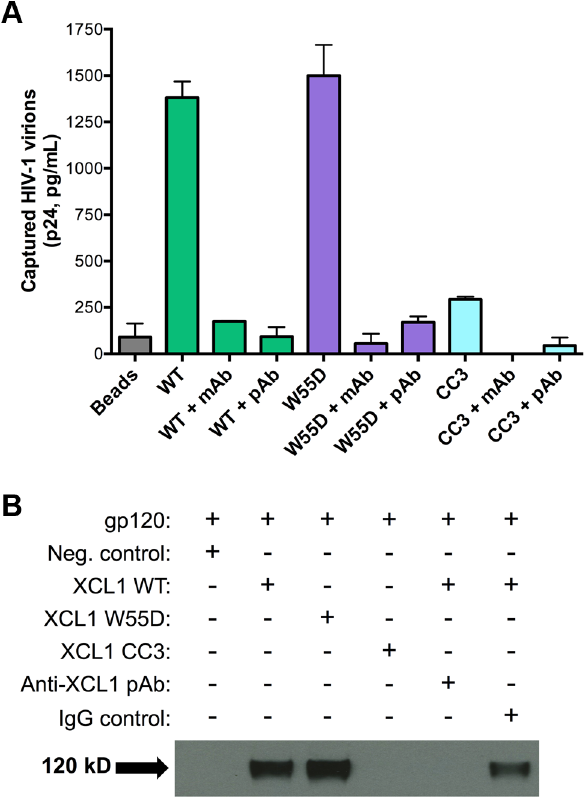
Figure 5. XCL1 captures native HIV-1 virions and interacts directly with the external viral envelope glycoprotein, gp120. (A) The virion capture assay was performed using immunomagnetic beads armed with 3 different XCL1 variants (WT in green bars, W55D in purple bars, and CC3 in light blue bars) as molecular baits to capture whole HIV-1 virions (strain IIIB; X4). The specificity of the interaction was demonstrated upon pre-incubation of XCL1-armed beads (prior to virus addition) with 20 m g/mL of monoclonal (mAb) and polyclonal (pAb) anti-XCL1 antibodies. (B) Co-immunoprecipitation of the HIV-1 enve- lope glycoprotein gp120 observed with XCL1 WT and W55D, but not CC3. From left to right: lane 1 showing a negative-control (unconju- gated XCL1 WT plus gp120); lane 2 with biotinylated XCL1 WT and gp120 co-precipitated; lane 3 with biotinylated XCL1 W55D and gp120 co-precipitated; lane 4 with no co-precipitation of biotinylated XCL1 CC3 and gp120; lane 5 with complete inhibition of XCL1 WT-gp120 co- precipitation in the presence of anti-XCL1 pAb; and lane 6 with IgG control showing minimal inhibition on XCL1-gp120 co-precipitation.